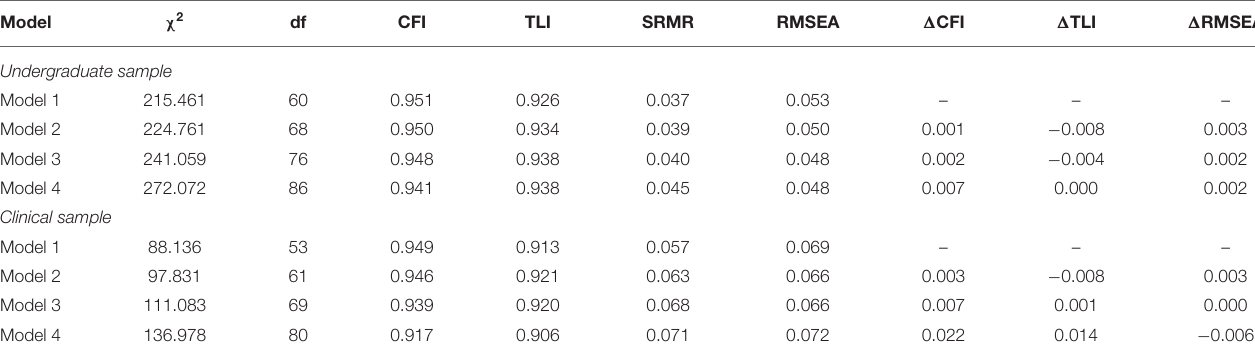
TABLE 6 | Measurement invariance of the RRS-10 across gender. Model